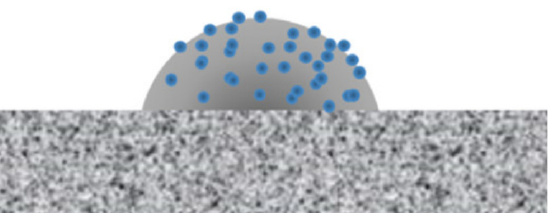
Figure 3. Aggregate with titanium dioxide on the surface of a photocatalytic mortar. Adapted with permission from Ref. [25]. Copyright 2019,